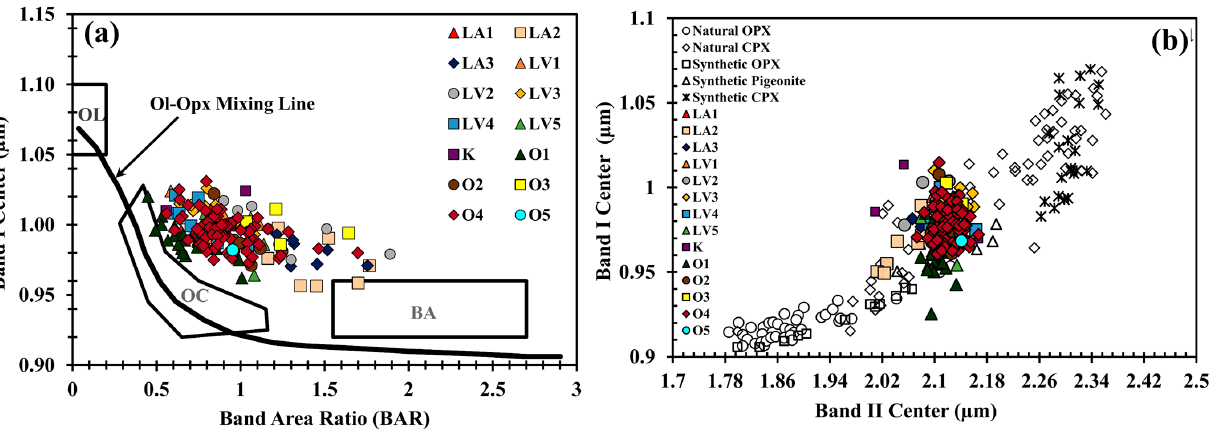
Figure 4. ( a ) BAR vs BC I graph [44]. The area of the OC polygon corresponds to mafic silicate com- position of ordinary chondrites, whereas the BA rectangular region represents pyroxene-dominated basaltic achrondrites [44]. ( b ) BC II vs BC I (corrected) graph of pyroxene spectra from the mare units. ( c ) Pyroxene quadrilateral (Wo–En–Fs ternary) graph projecting the mole fraction of Ca, Mg, and Fe content in pyroxenes from each mare unit, along with the pyroxene isotherm determined by the graphical thermometer generated by [25]. ( d ) Comparison between the pyroxene chemistry of the mare units and that of the Apollo, Luna, Chang ‘E-5 (CE-5), and other lunar meteorite samples [41,42,45,46]. The Orientale basin’s young mare deposits are contemporaneous with the young vol- canic deposits discovered at PKT on the lunar nearside [31]. The peak volcanic eruptions, which occurred around 2 Ga, were not restricted to the PKT but also covered other parts of the Moon. The volcanism in the Orientale basin lasted about ~1.9 Ga (from the Imbrium to the Eratosthenian period), thus it is highly likely that the underlying mantle had a high initial temperature and/or a high concentration of radioactive sources [31]. 4. Conclusions The non-mare region of the Orientale basin shows a spectral mixture of plagioclase and mafic materials, indicating the exposure of upper crustal anorthositic rock. The mafic signature might be from the impact melt sheet that formed during the modification of the Orientale basin, which was later exposed by excavating the upper layer of the crust during the impacts that occurred after the basin’s development. The basaltic materials to the southwest of the Orientale basin are found to contain the olivine (troctolite or dunite), clinopyroxene, and cumulate of clinopyroxene and plagioclase (anorthositic gabbro or gabbroic anorthosite) that is plausibly the remnant of the lunar magma ocean and subse- quent magmatic intrusions into the crust. The other probable origin might be from the derivation of deep lower-crustal or upper-mantle sources. The southeastern basaltic